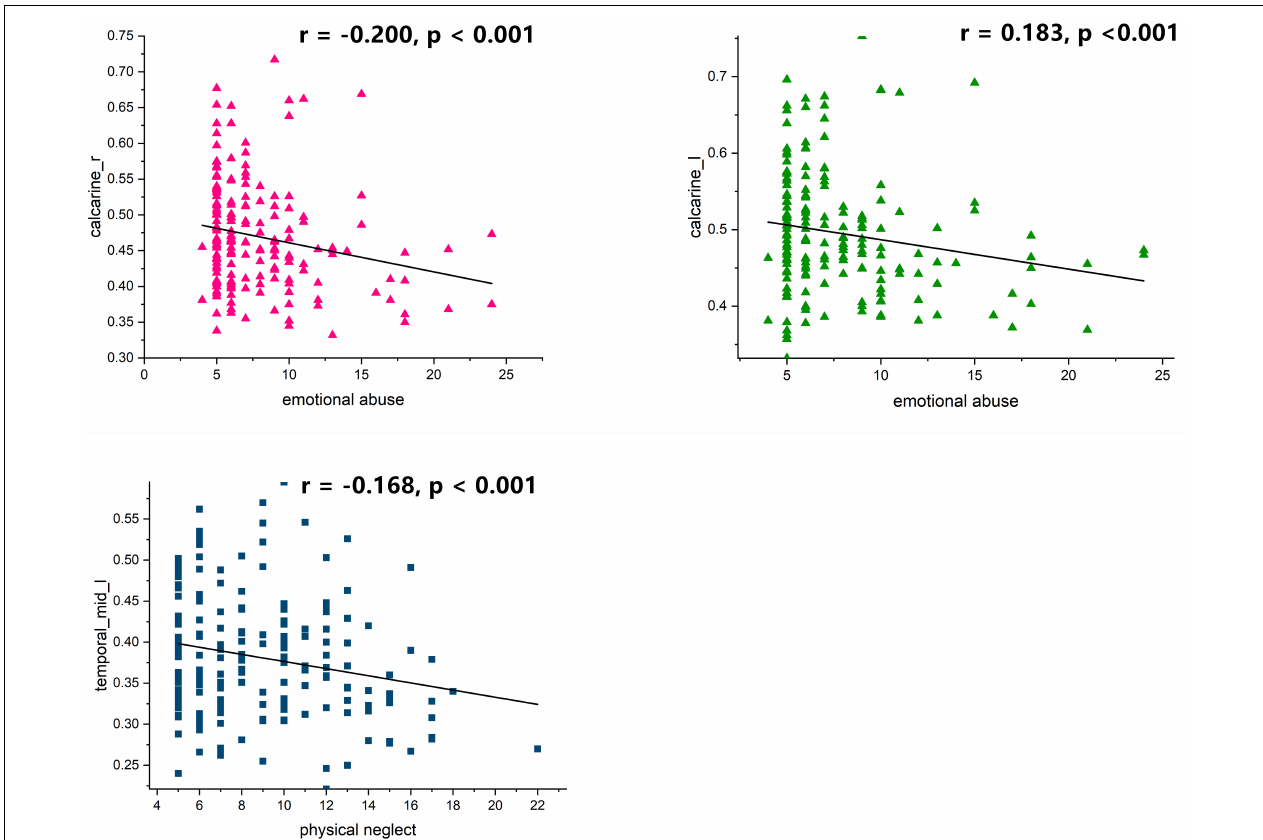
FIGURE 4 | Correlation between childhood trauma history and voxel wise